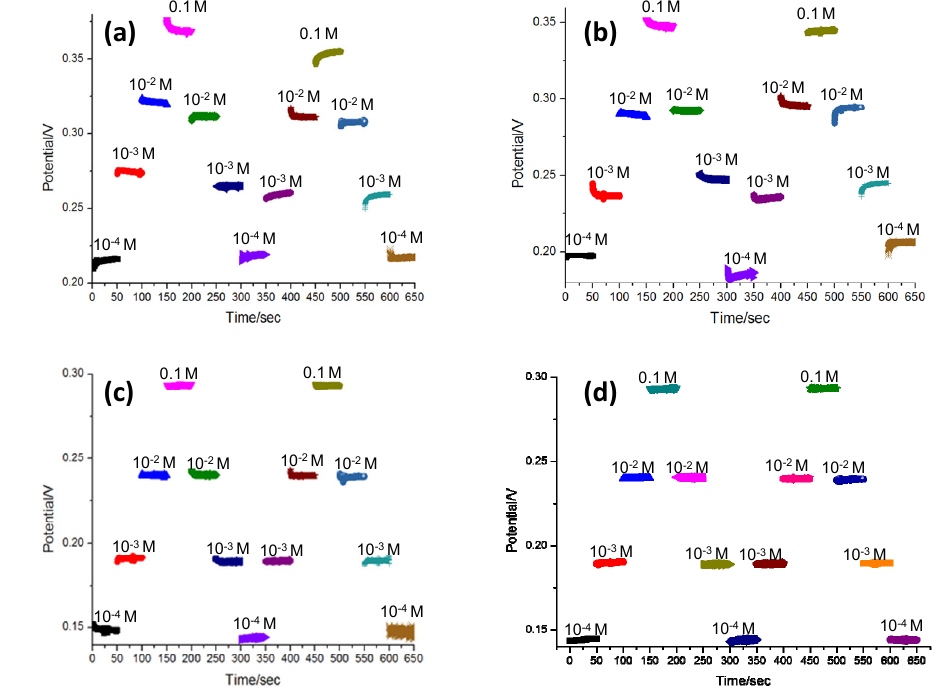
Figure 7. The reversibility of the potentiometric NH 4+ detection using sensors ( a , b ) without and ( c , d ) with 3D Graphene–CNT modi fi ed electrodes, respectively.